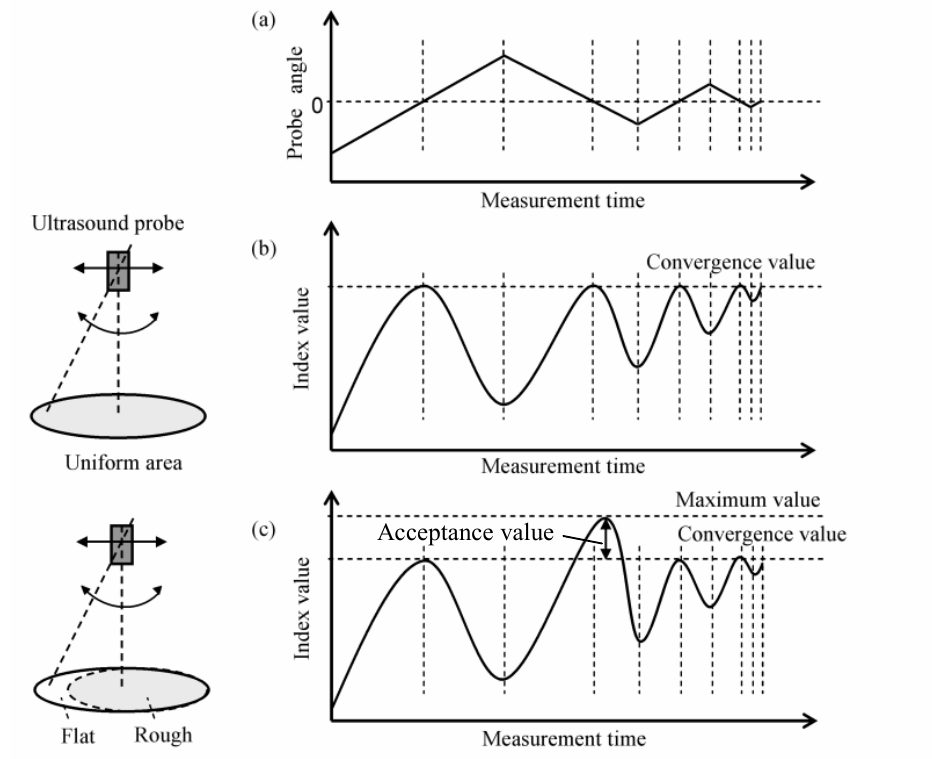
Figure 8: The probe angle alignment model. (a): The time course of probe angle. (b): The time course of the index in the measurement of uniform area. (c): The time course of the index in the measurement of the rough surface near the flat